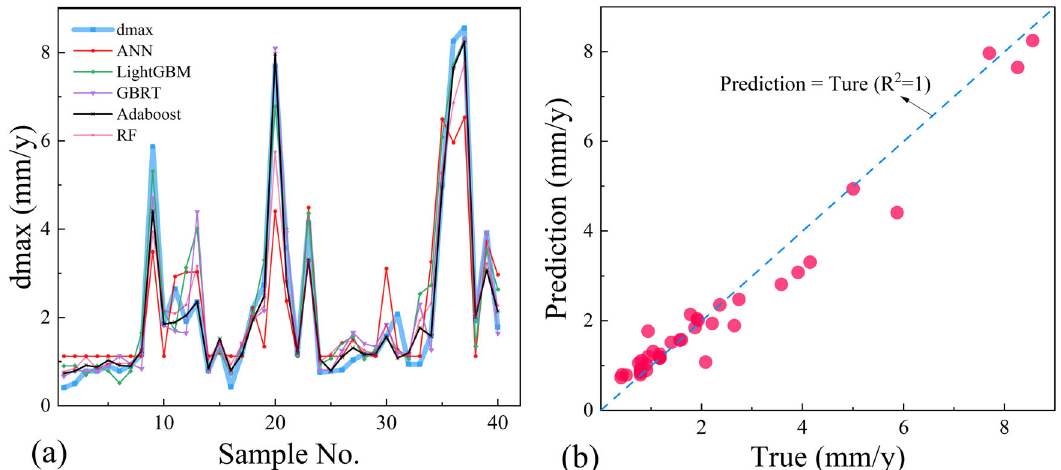
Fig. 2 Prediction results of models. a Predictions of different models on the test set, b scatter plot of predictions using Adaboost